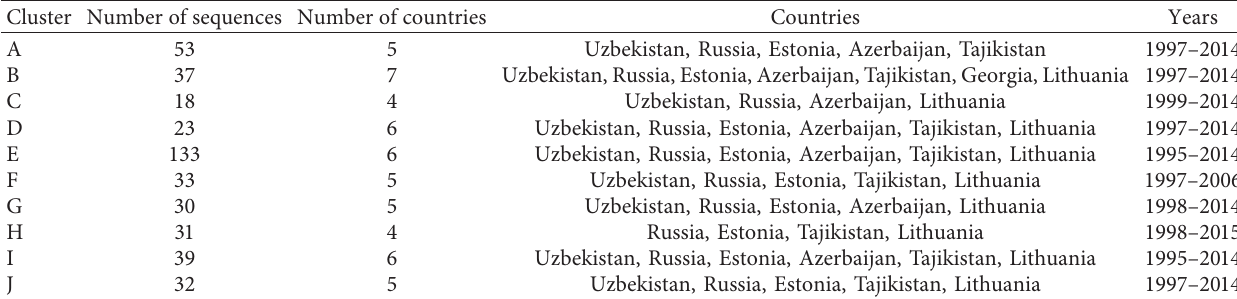
Table 1: Cluster analysis of HCV 1b NS5B tree in Figure 1 showing distribution of sequences among FSU countries. Cluster Number of sequences Number of countries